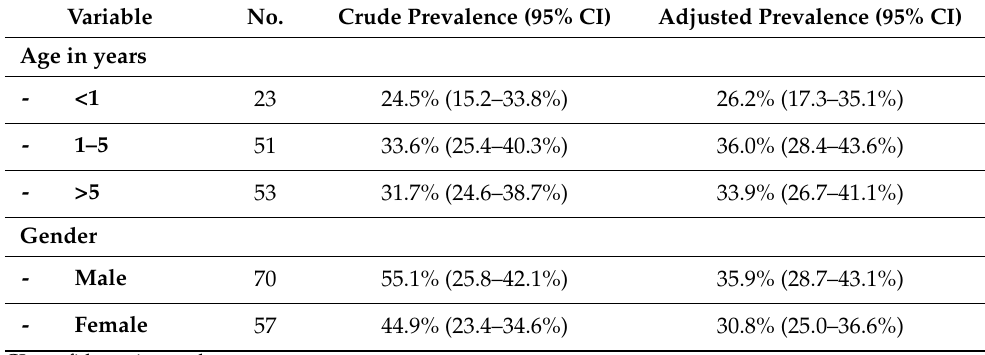
Table 3. Crude and adjusted seroprevalences values of COVID-19 antibodies among children by their age and gender the in Aseer region, Saudi